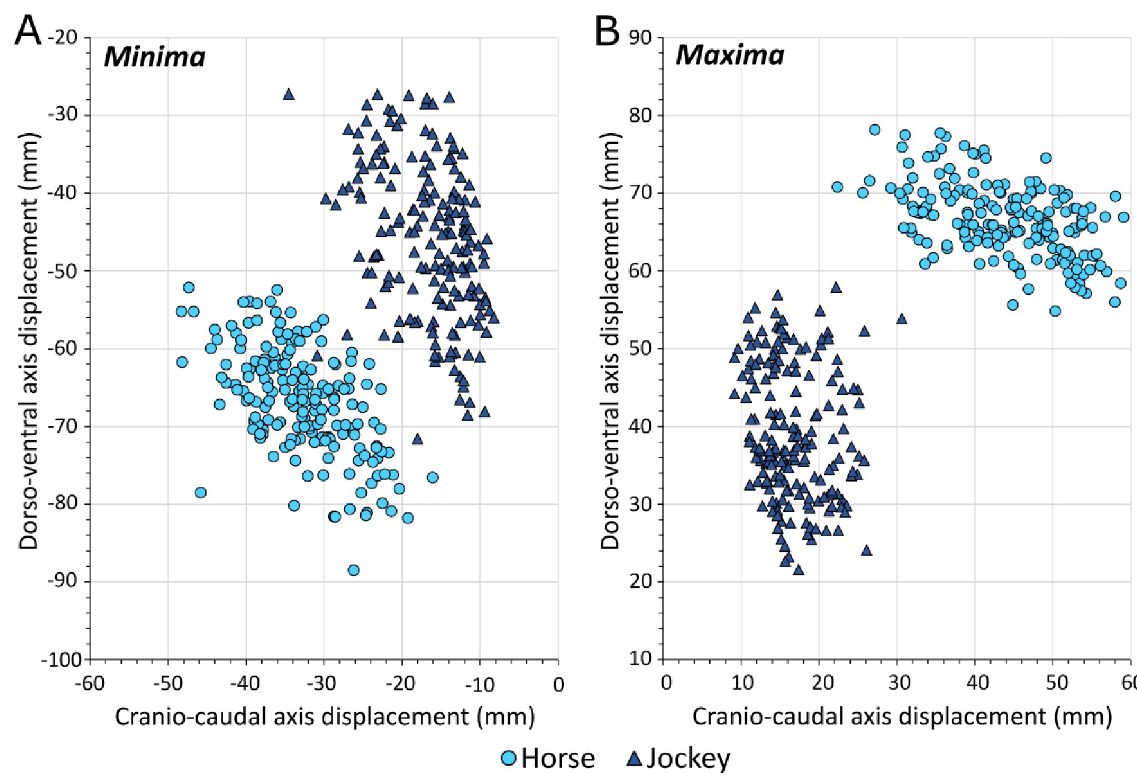
Fig 6. Relationship between the magnitude of dorso-ventral (DV) axis and cranio-caudal (CC) axis displacements for horse and jockey individual trial data. A . Minima. B .